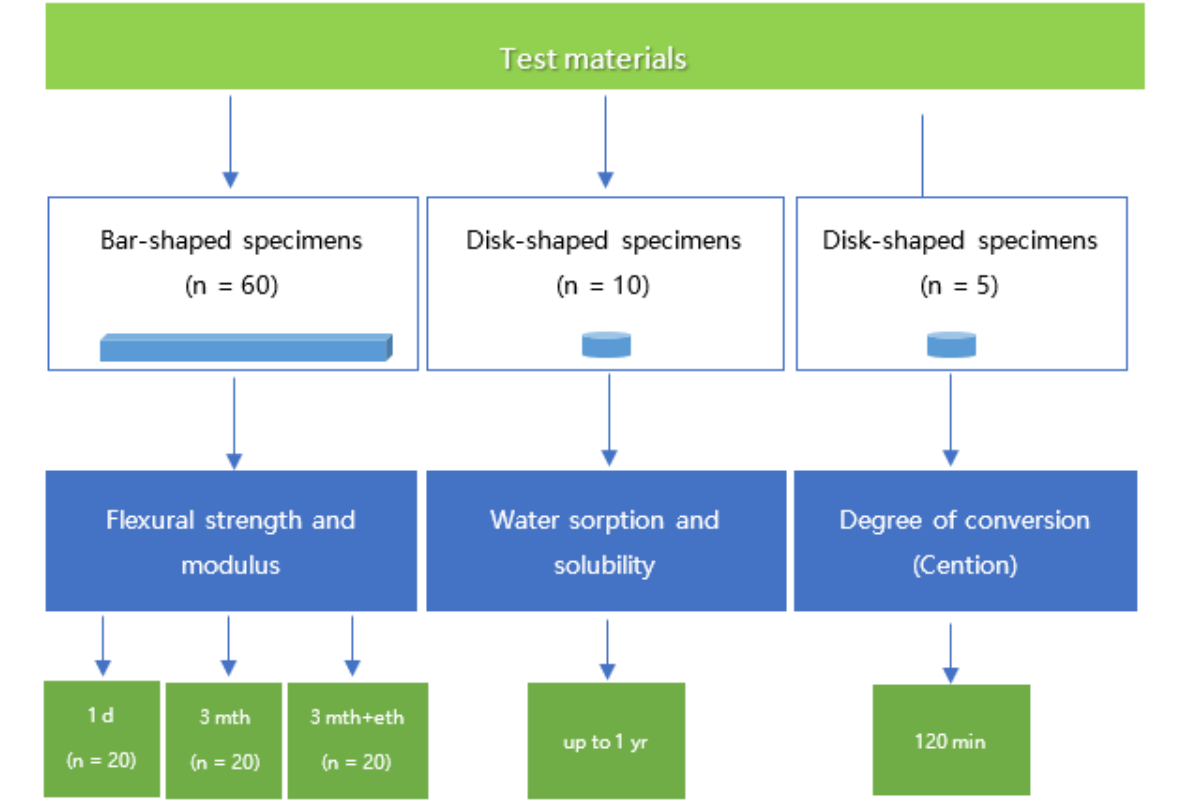
Figure 1. Flow chart of the study design.